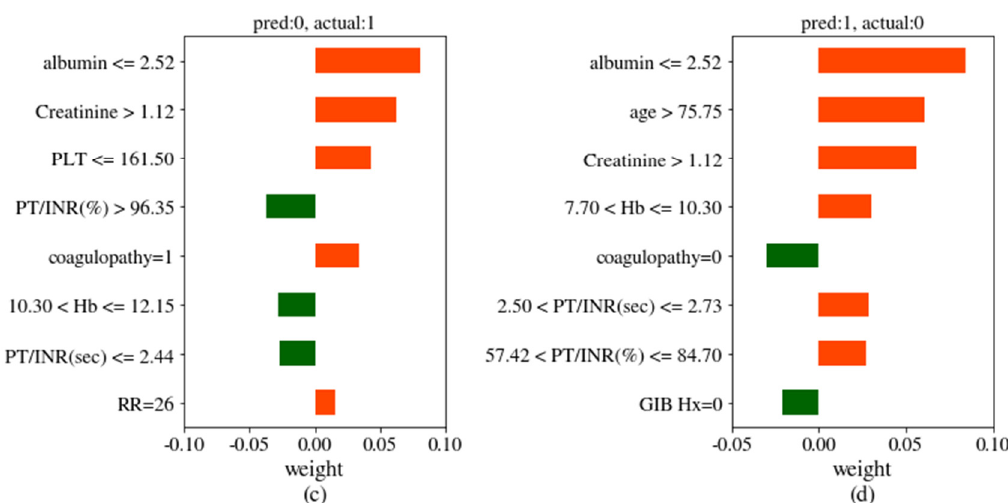
Figure 4. LIME (local interpretable model-agnostic explanation) explanation of true-negative ( a ), true-positive ( b ), false-negative ( c ), and false-positive ( d ) cases for the RF when the outcome is mortality. The orange bars are the variables that support the positive and the green bars are the variables supporting the negative. The larger the absolute value of weight, the greater the effect of the predicting outcome, mortality. See Table A1 for variable names.